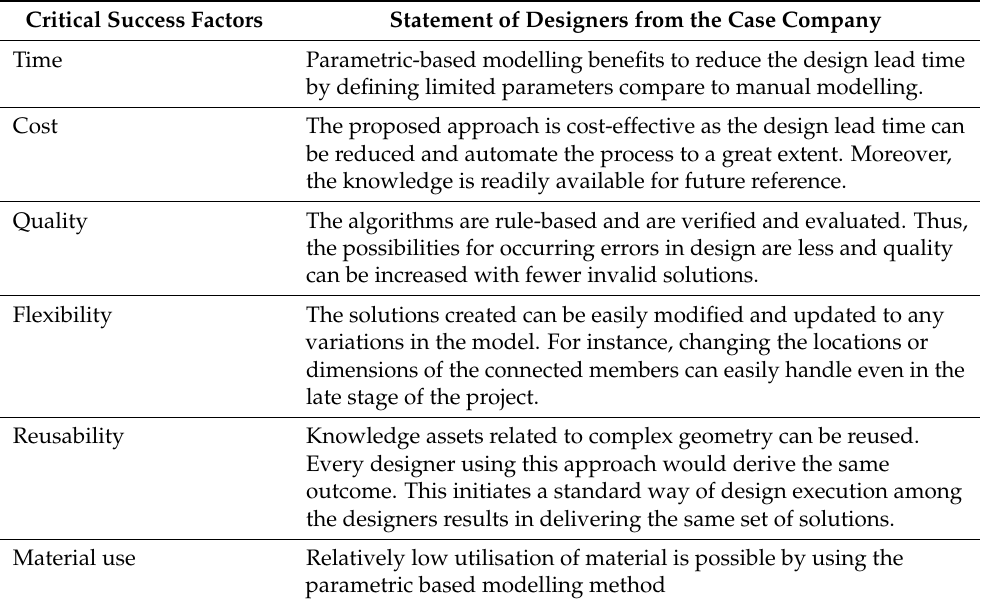
Table 2. Evaluation of selected critical success factors in the design